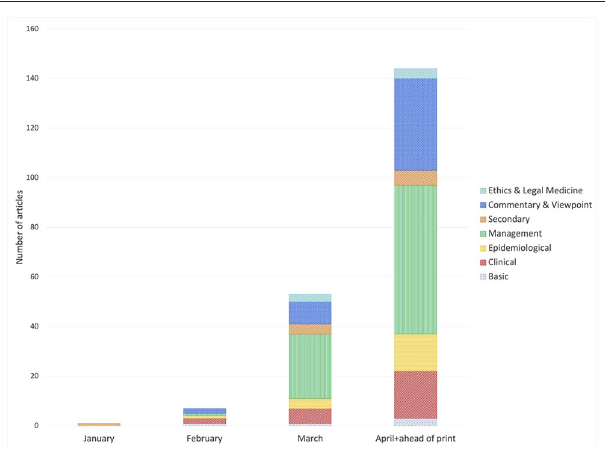
FIGURE 3 | Italian articles published each month, by type of